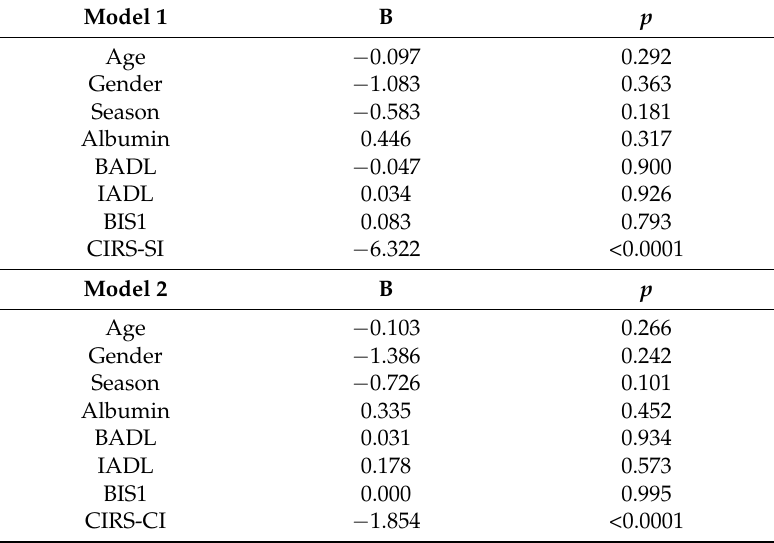
Table 4. Linear regression analyses to assess whether comorbidities burden is associated with 25(OH)D concentrations controlling for multiple confounding factors ( n =